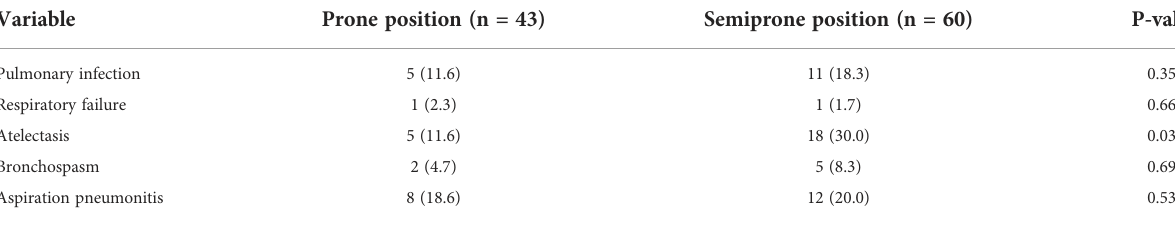
TABLE 3 Postoperative pulmonary complications between the prone position and semiprone position group. Variable